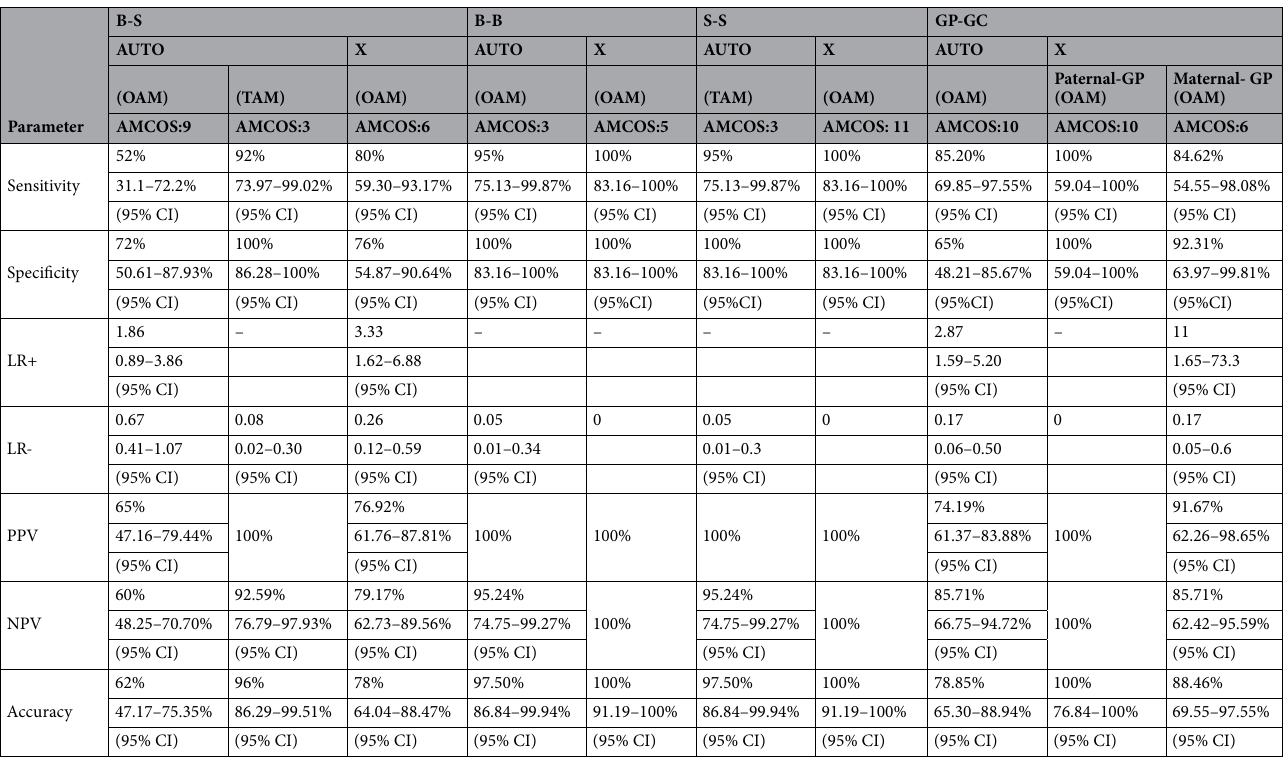
Table 11. Sensitivity, specificity, positive predictive value (PPV), negative predictive value (NPV), positive likelihood ratio (LR +), negative likelihood ratio (LR-) and accuracy of AMCOS method in various types of kinship analyses. Data showed as parameter value (95% confidence